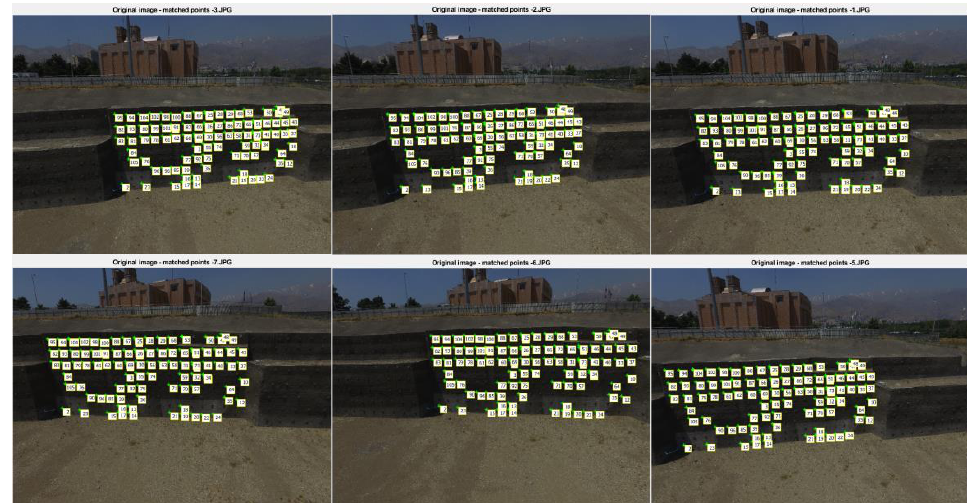
Figure 15. Example of the results of correspondence matching on the UAV-captured observations over the Seoul excavation project.